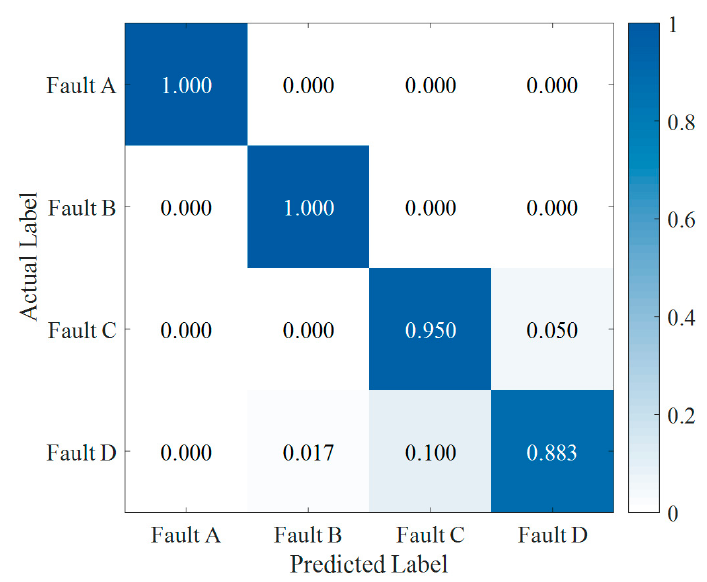
Figure 10. Confusion matrix of the classification results using SVM. Table 5. The results of different diagnosis models for metal particle fault.